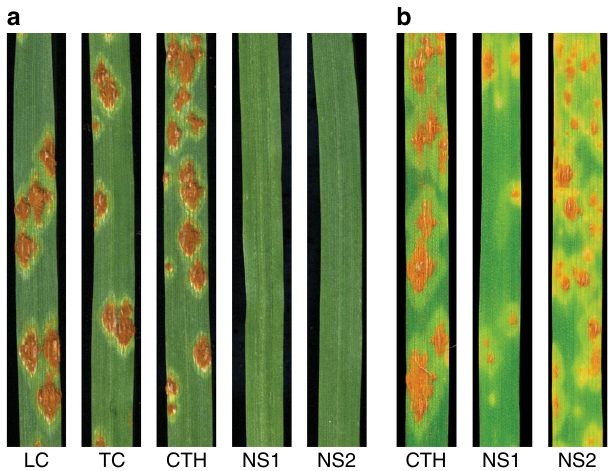
Fig. 1 Mutation in SuSr-D1 activates wheat stem rust resistance. a